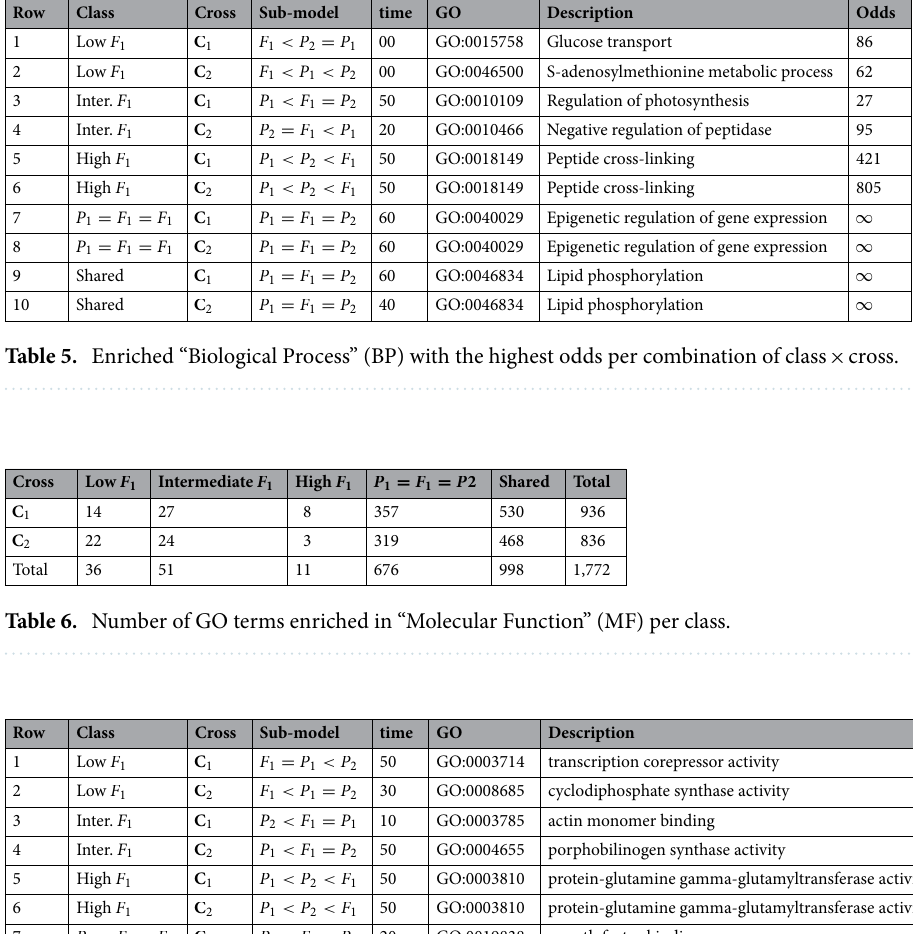
Table 7. Enriched “Molecular Function” (MF) with the highest odds per combination of class × cross.